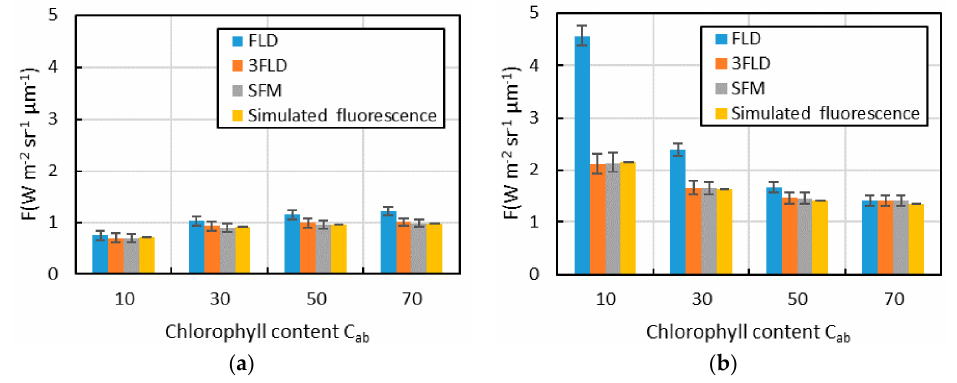
Figure 6. The fluorescence extraction results for each algorithm and the simulated value of fluorescence for data with different chlorophyll contents (the rectangle in this Figure is the mean fluorescence, and the error lines are the standard deviation values); ( a ) O 2 -A absorption band; ( b ) O 2 -B absorption band.